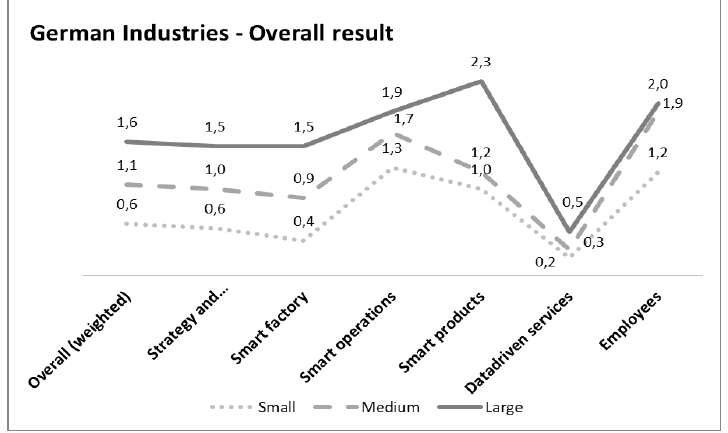
Figure 3. Overall result of Industry 4.0 maturity evaluation of German companies by size [7].